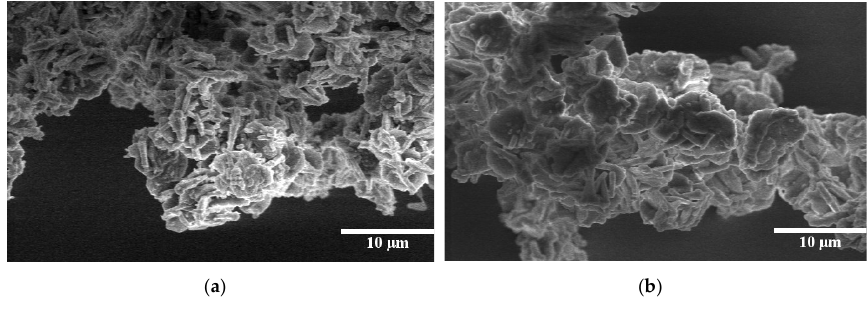
Figure 7. Scanning electron micrographs of: ( a ) PMO-S; ( b ) Ti-PMO-S materials.